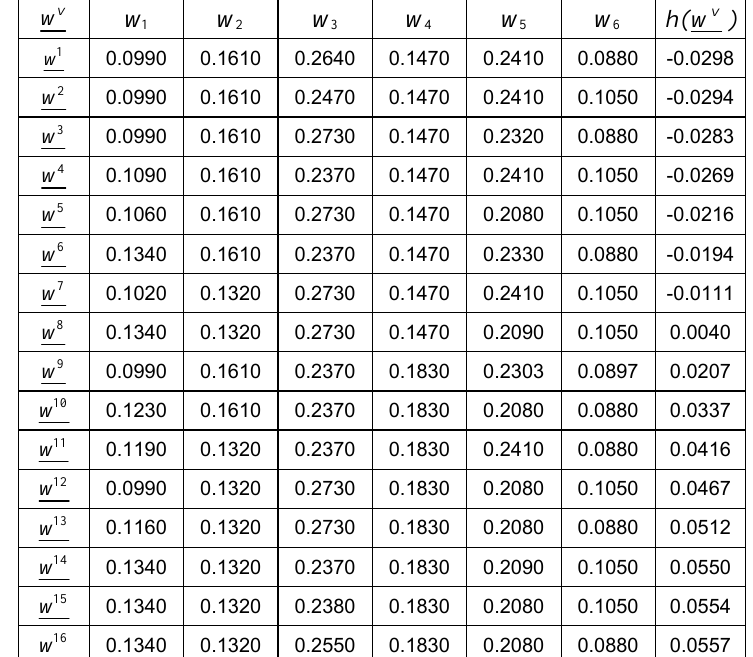
Table 5 – Vertices of the set E Таблица 5 – Вершины множества E Табела 5 – Врхови скупа